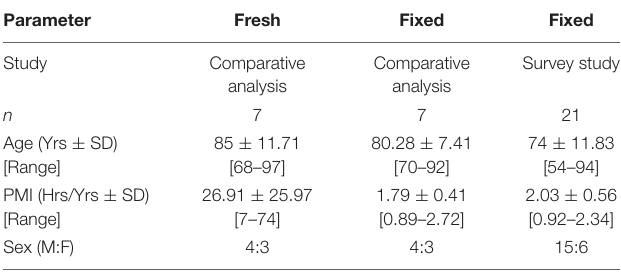
TABLE 5 | Demographic information for subjects used in this